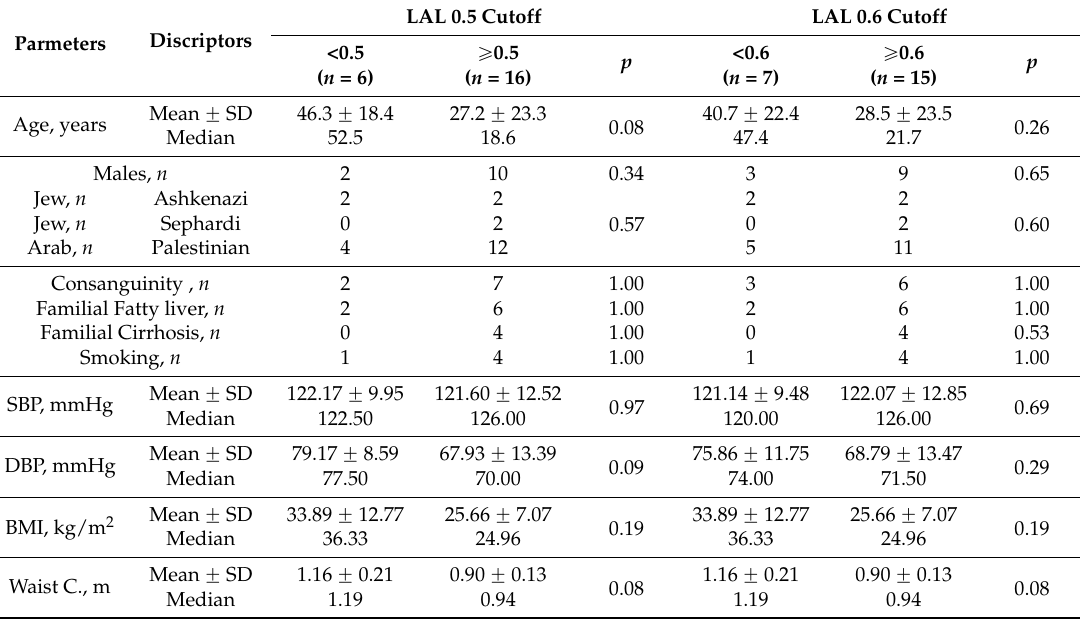
Table 3. Baseline characteristics of participants according to LAL